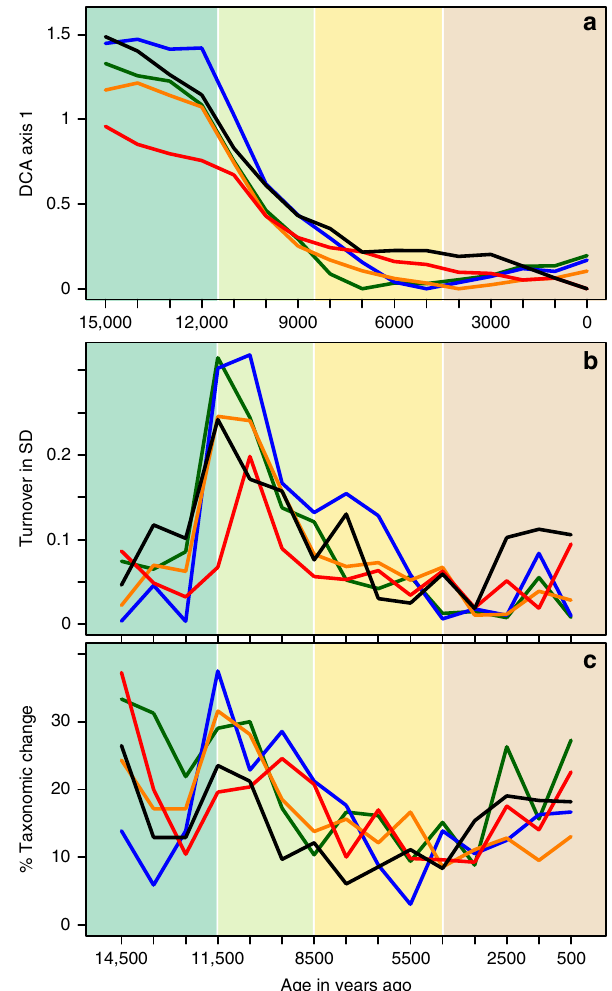
Fig. 3 Compositional and taxonomic turnover of regionally combined samples assessed through detrended correspondence analysis (DCA), its constrained version (DCCA) and the number of different taxa in adjacent time-slices. Colour coding as in Fig. 1. a Scores of the fi rst DCA axis, summarising the overall change in composition including abundance changes. Note that the gradient is shortest for the Meridional/ Submeridional region and that samples from the Boreal and Temperate regions dating between 7 and 4 ka mark the end of the gradient, which is more pronounced when rare taxa are ignored (Supplementary Fig. 7, Supplementary Table 1). b Between-sample differences in the scores of the fi rst, time constrained DCCA axis indicating that the highest compositional change between any two samples occurred at the onset of the Holocene in the Boreal and Temperate Oceanic regions. c The percentage of taxonomic change between consecutive samples of taxa with an abundance >0.1%, with taxa harmonised at a higher taxonomical combination H 2 (see Supplementary Fig. 8 for H 0